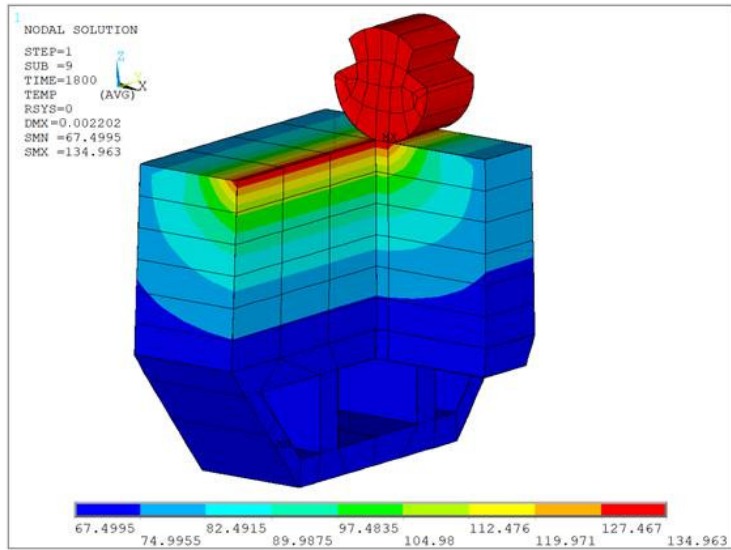
Figure 10. Temperature ( a ), ( c ) and gradient temperature ( b ) in the cross-section of the copper headline.